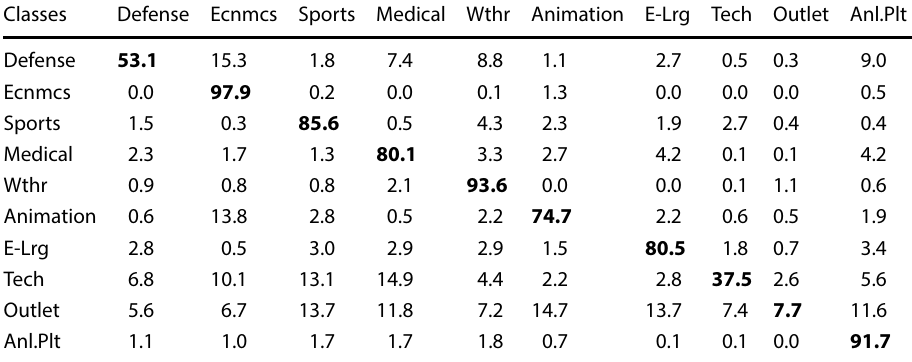
Bold indicates the